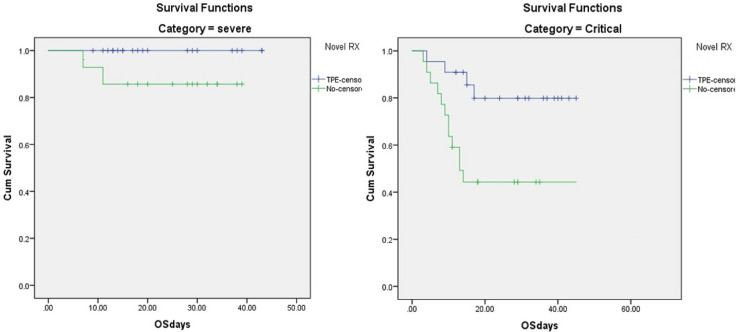
Survival comparison in severe and critical COVID-19 between TPE and non-TPE cohorts.(a) For severe COVID-19 patients, OS of 100% and 90% (p = 0.08) in TPE and non- TPE patients respectively (b) for critical COVID-19 patients, OS of 81.8% and 40.9% (p = 0.007) in TPE and non TPE patients respectively. COVID-19, Coronavirus disease 2019, TPE, Therapeutic Plasma exchange, OS, overall survival.